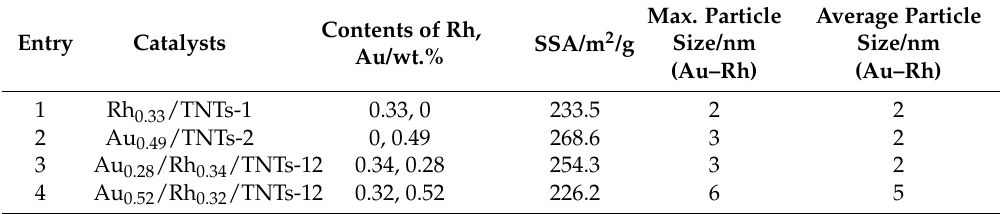
Table 1. Contents of Rh and Au in catalysts and the specific surface area of the prepared